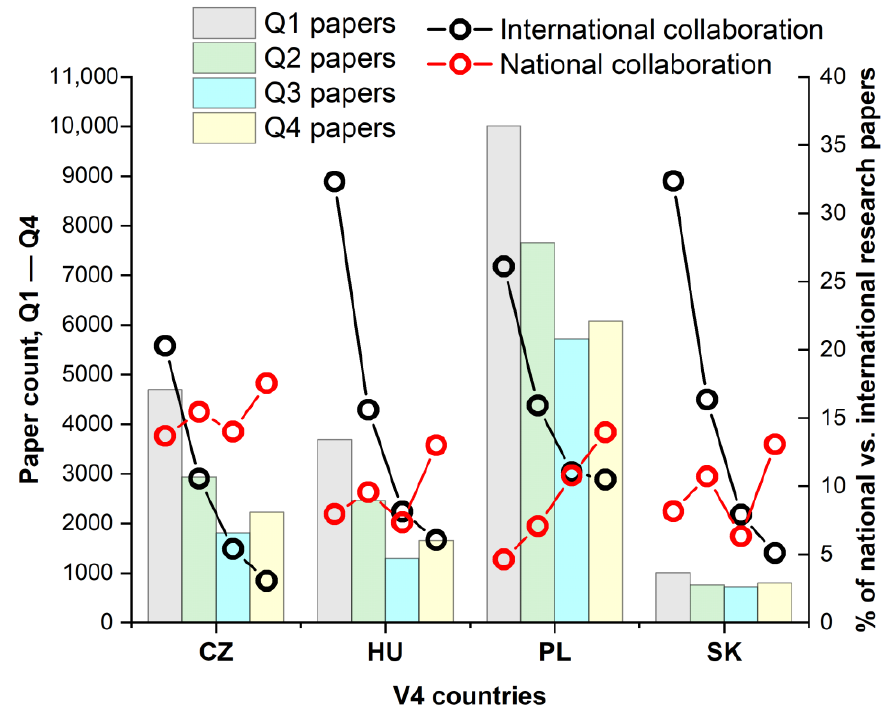
Figure 1. The total number and distribution of all papers and research articles in national and international collaboration among V4 countries as a function of the JIF quartile. The left Y axe shows the total number of paper counts. The right Y axe shows the percentage of research papers in international and national collaboration to all research articles for the given V4 country. Abbreviations: CZ = Czech Republic, HU = Hungary, PL = Poland, SK = Slovakia. Table 1. The total number of research papers in international and national collaboration as a function of the JIF quartile. The distribution of Q1–Q4 research papers for each V4 country in international and national collaboration was observed from the InCites database. N corresponds to the number of research articles; Internat. = international